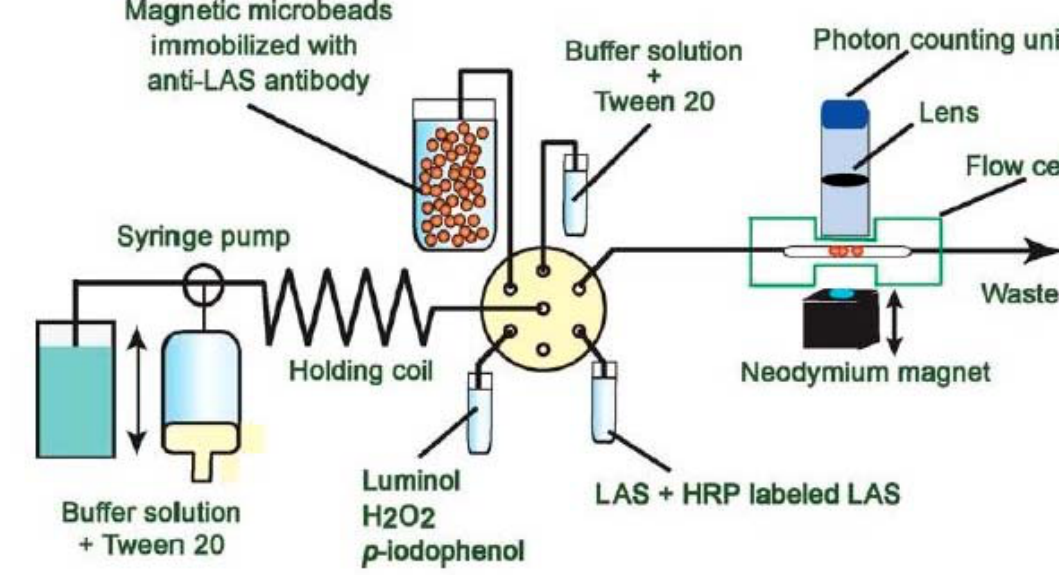
Figure 5 Schematic flow diagram of the sequential injection system using magnetic